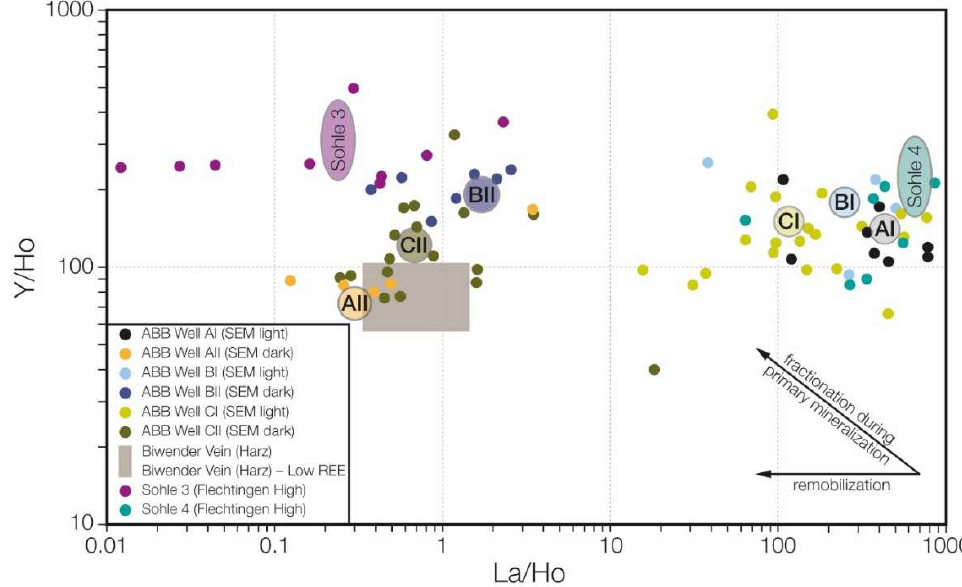
Figure 10. La/Ho versus Y/Ho plot for a selection of fluorite samples from the ABB and the Flechtingen High. The grouping and colours correspond to those in Figure 5 . See text for discussion.